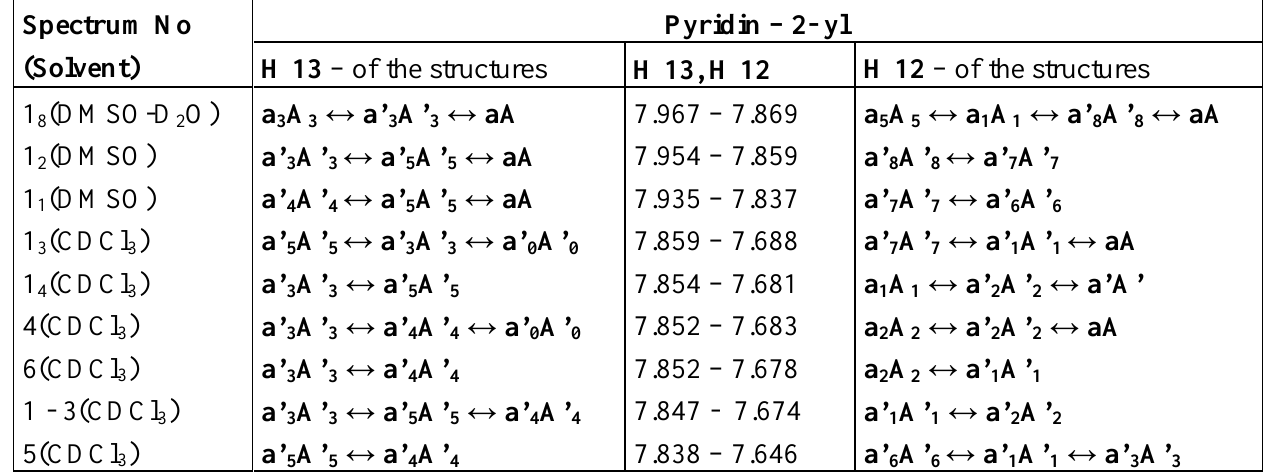
Table 5 . The 1 H-NMR chemical shifts δ [ppm] from TMS of 1 .